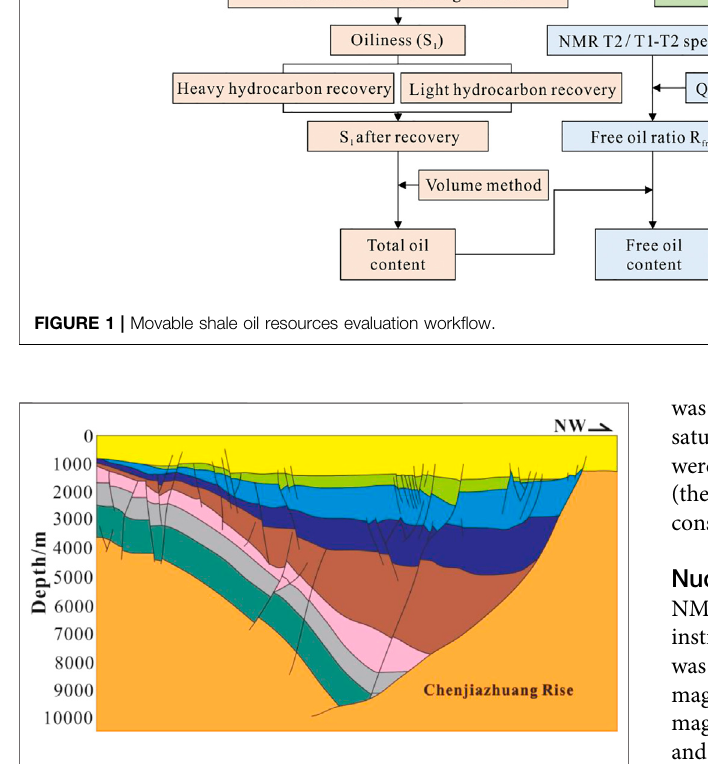
Frontiers in Earth Science |